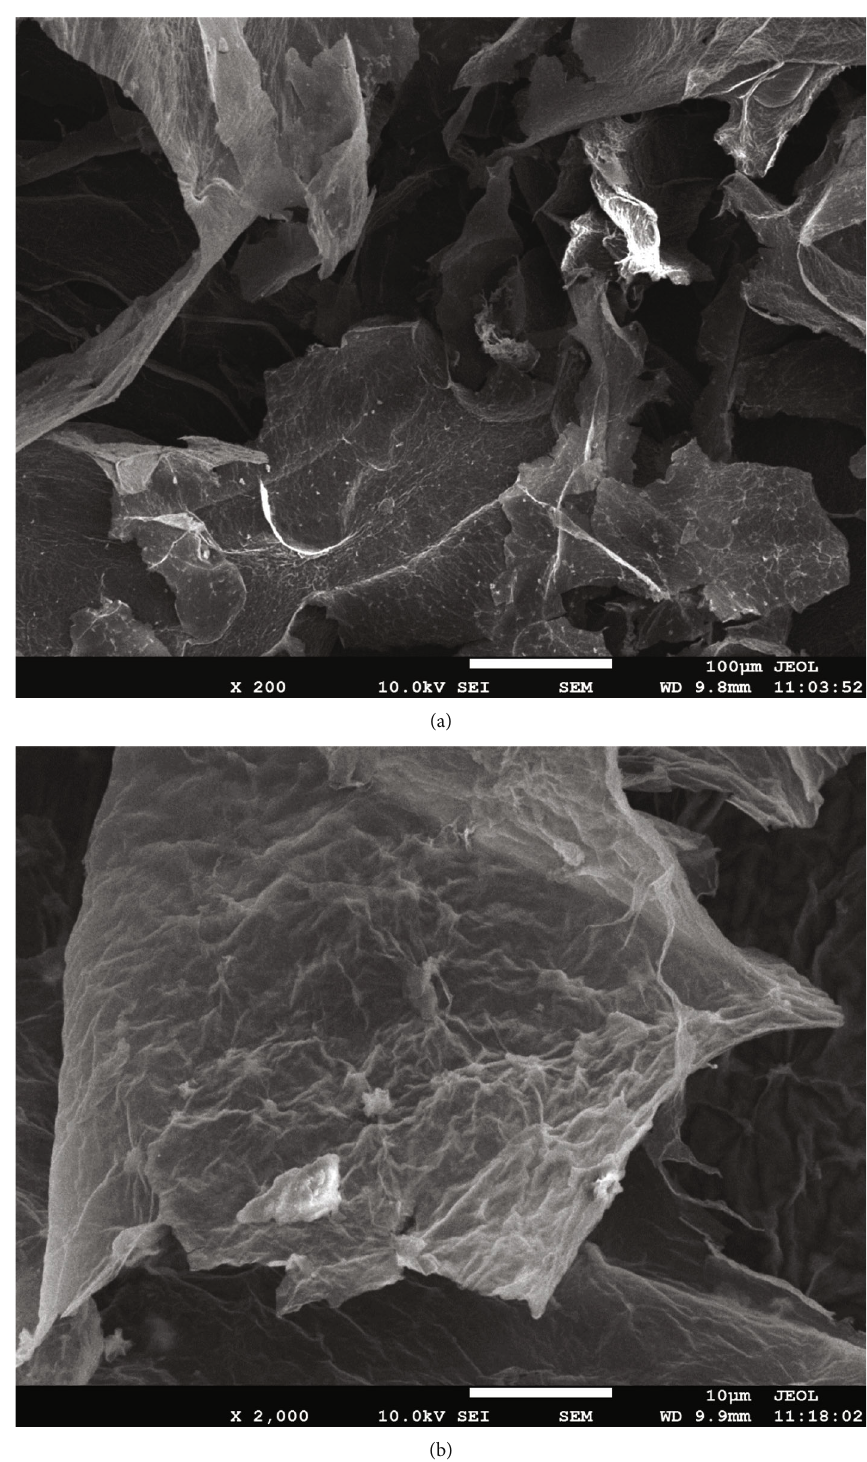
Figure 4: SEM images of